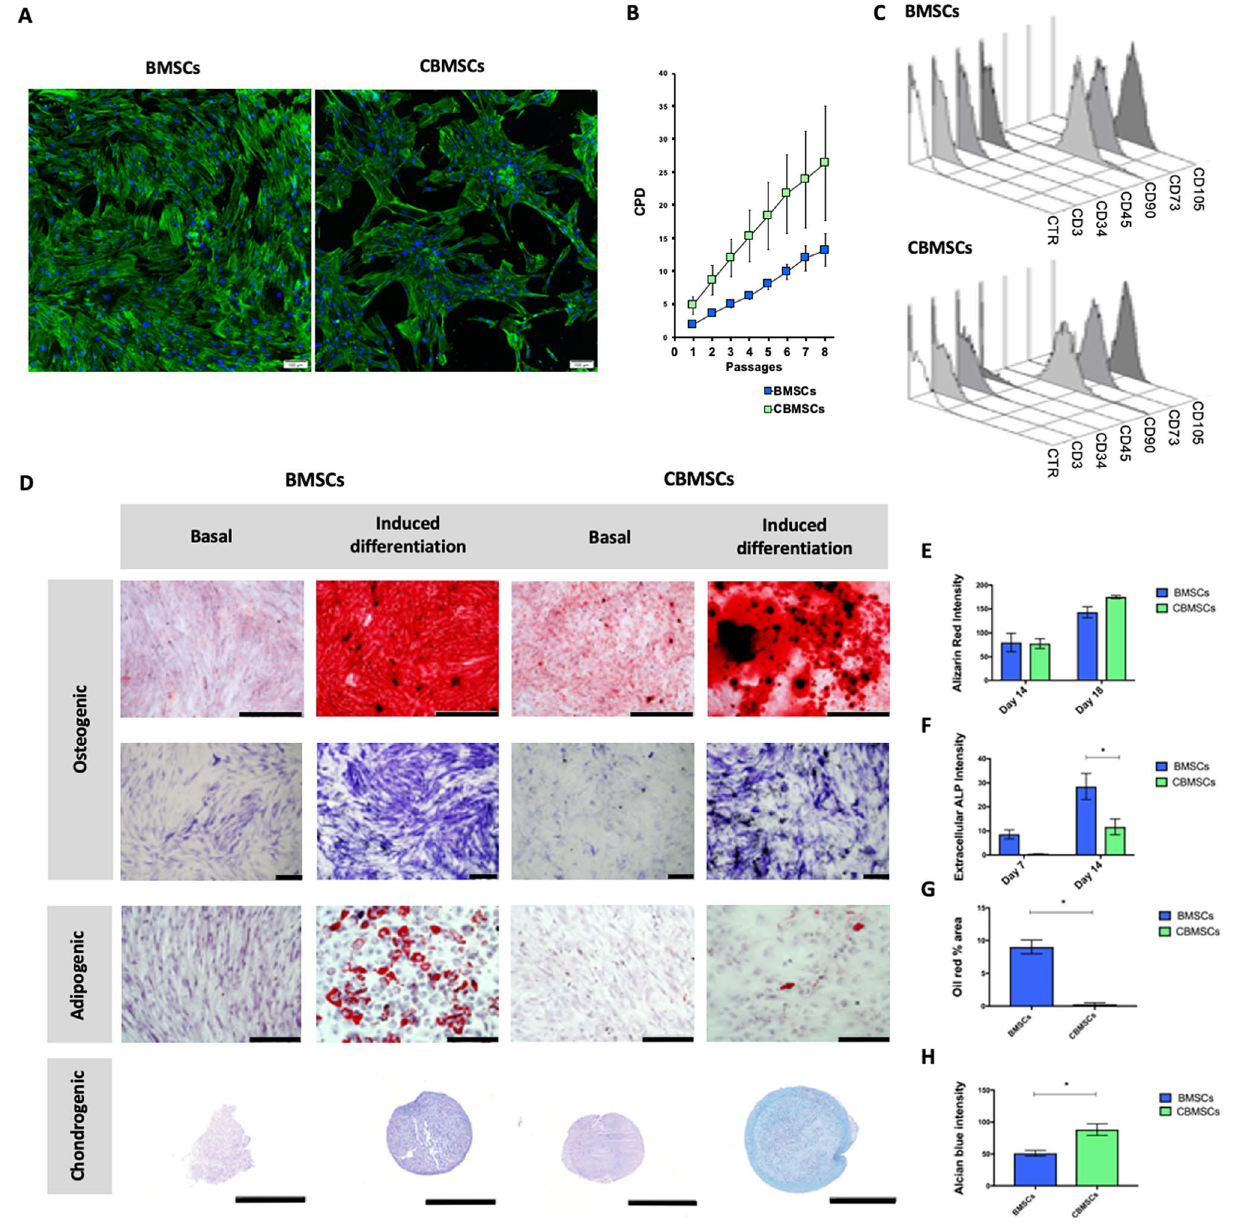
Figure 1. Characterization of BMSCs and CBMSCs. ( A ) Cell morphology as illustrated by DAPI nuclear, and phalloidin actin cytoskeleton fluorescent staining. Scale bars represent 200 μm. ( B ) Growth curve is represented as Mean ± standard deviation (SD) of cumulative population doublings (CPD) for passage 1–8. ( C ) Phenotypic characterization by flow cytometry of BMSCs and CBMSCs shows positive expression of stem cell surface markers CD105, CD90, CD73, and negative expression for CD45, CD34, and CD3. ( D ) Representative images of in vitro tri-lineage differentiation potential of BMSCs and CBMSCs towards osteogenic, adipogenic, and chondrogenic lineages confirmed by histochemical staining with Alizarin red and Alkaline phosphatase, Oil red O, and Alcian blue, with scale bars representing 500 μm, 200 μm, 200 μm, and 500 μm, respectively. ( E ) Quantitative measurement of solubilized bound Alizarin red stain of both BMSCs and CBMSCs induced with osteogenic supplements after 7 and 14 days. ( F ) Extracellular ALP staining quantification after 7 and 14 days of osteogenic priming. ( G ) Quantification of lipid droplet area in images of oil red staining following adipogenic induction of BMSCs and CBMSCs. ( H ) Quantification of Alcian blue colour intensity of sections through pellets of BMSCs and CBMSCs that underwent chondrogenic priming. Data is presented as Mean ± standard error of the mean (SEM). Statistical analysis was by unpaired Student’s t -test for single experimental condition ( B , G , H ) and by two-way ANOVA followed by Holm–Sidak’s multiple comparison test for multiple experimental conditions ( E , F ). *Significant difference between MSCs of different tissue